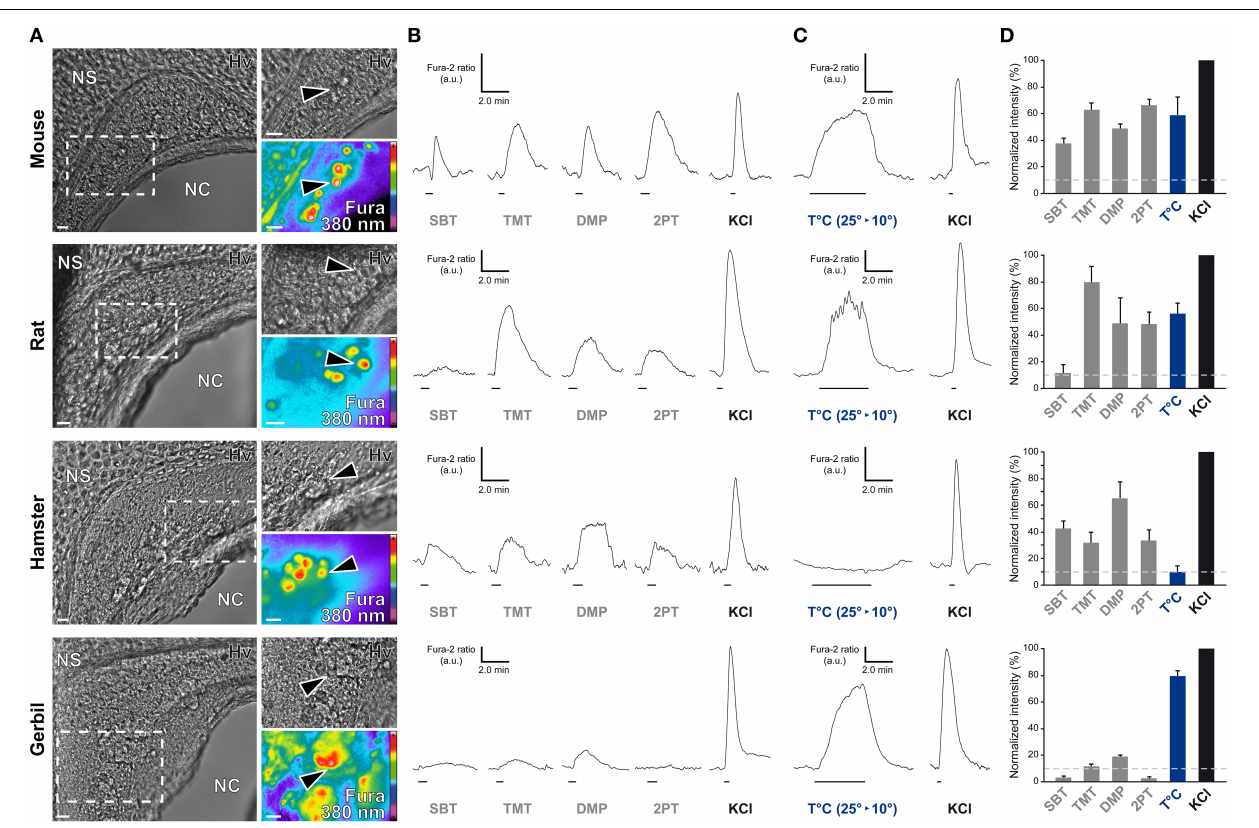
10 ◦ C). Here calcium increases are shown for mouse, rat and gerbil. In hamster, the illustrated chemo-responding neuron (in B ) did not respond to the thermal stimulation. (D) Histograms summarizing Fura-2 ratio peak calcium responses intensity to chemo- and thermo-stimulations (respectively in gray and blue bars) normalized to KCl responses (20mM; in black bars). 10% of KCl activity (gray dashed lines) was used as a limit for considering a neuronal response. Values are expressed as mean ± s.e.m. A minimum of 3 animals (mouse: from P0 to P6; rat: from P1 to P4; hamster: from P2 to P4; gerbil: from P0 to P3) and 6 slices were used for each species. Scale bars, 20 μ m in (A) . Fluorescence intensity Fura-2 ratio = F340/F380 is indicated by arbitrary units (a.u.) in (B) and (C) . Perfusion times for chemo- and thermo-stimulations are indicated by horizontal bars in (B) and (C)